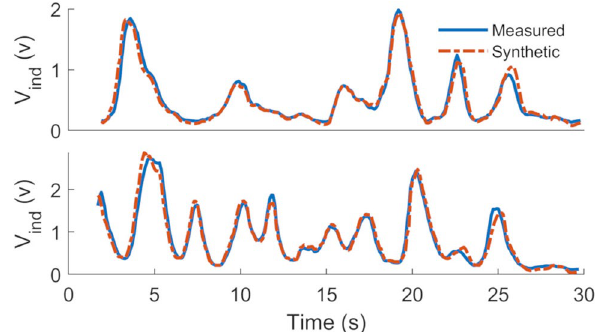
Figure 7. Measurement versus synthetic data. The measured and simulated induced voltage at the MI sensor during two different arbitrary movements, such that both relative alignment and location of the coil vary relative to the central